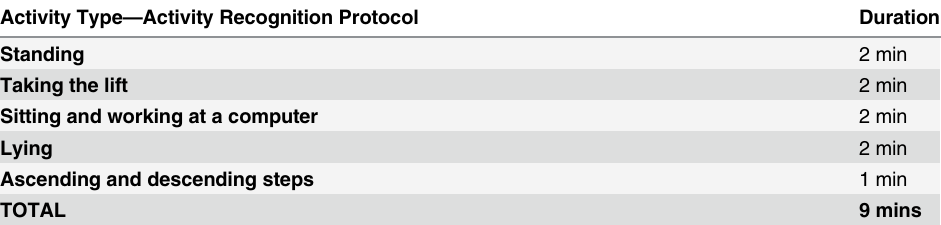
Table 4. Summary of the activities performed during the activity recognition